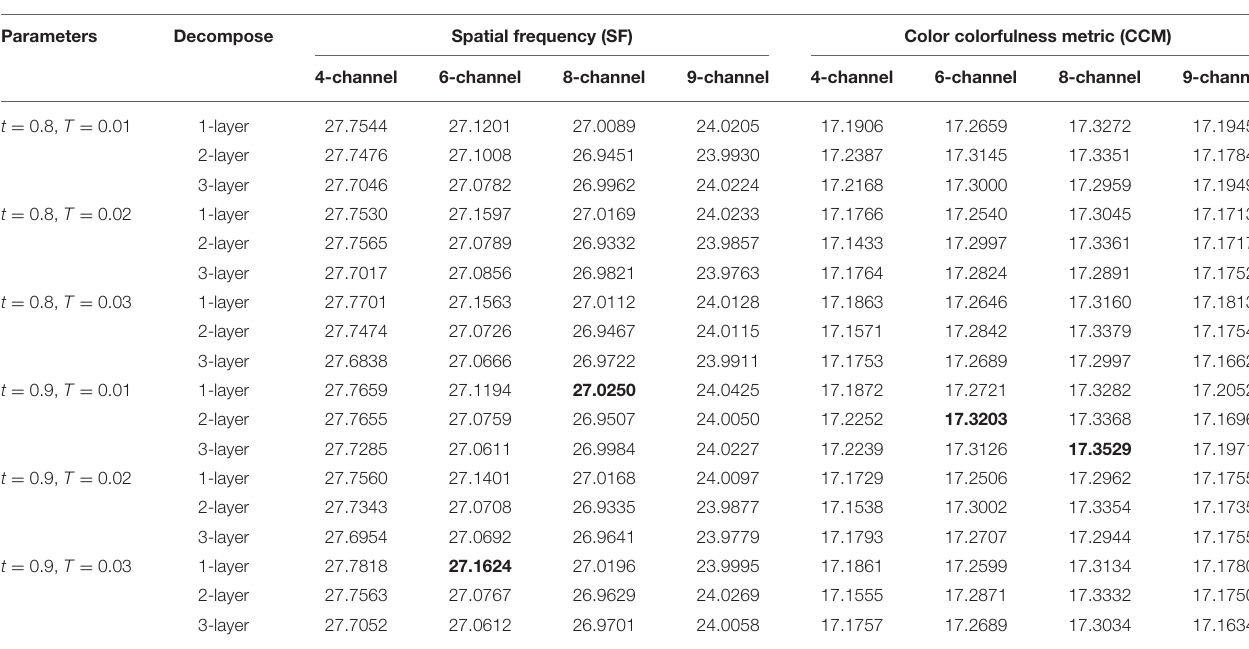
TABLE 1 | Selection of initial parameters